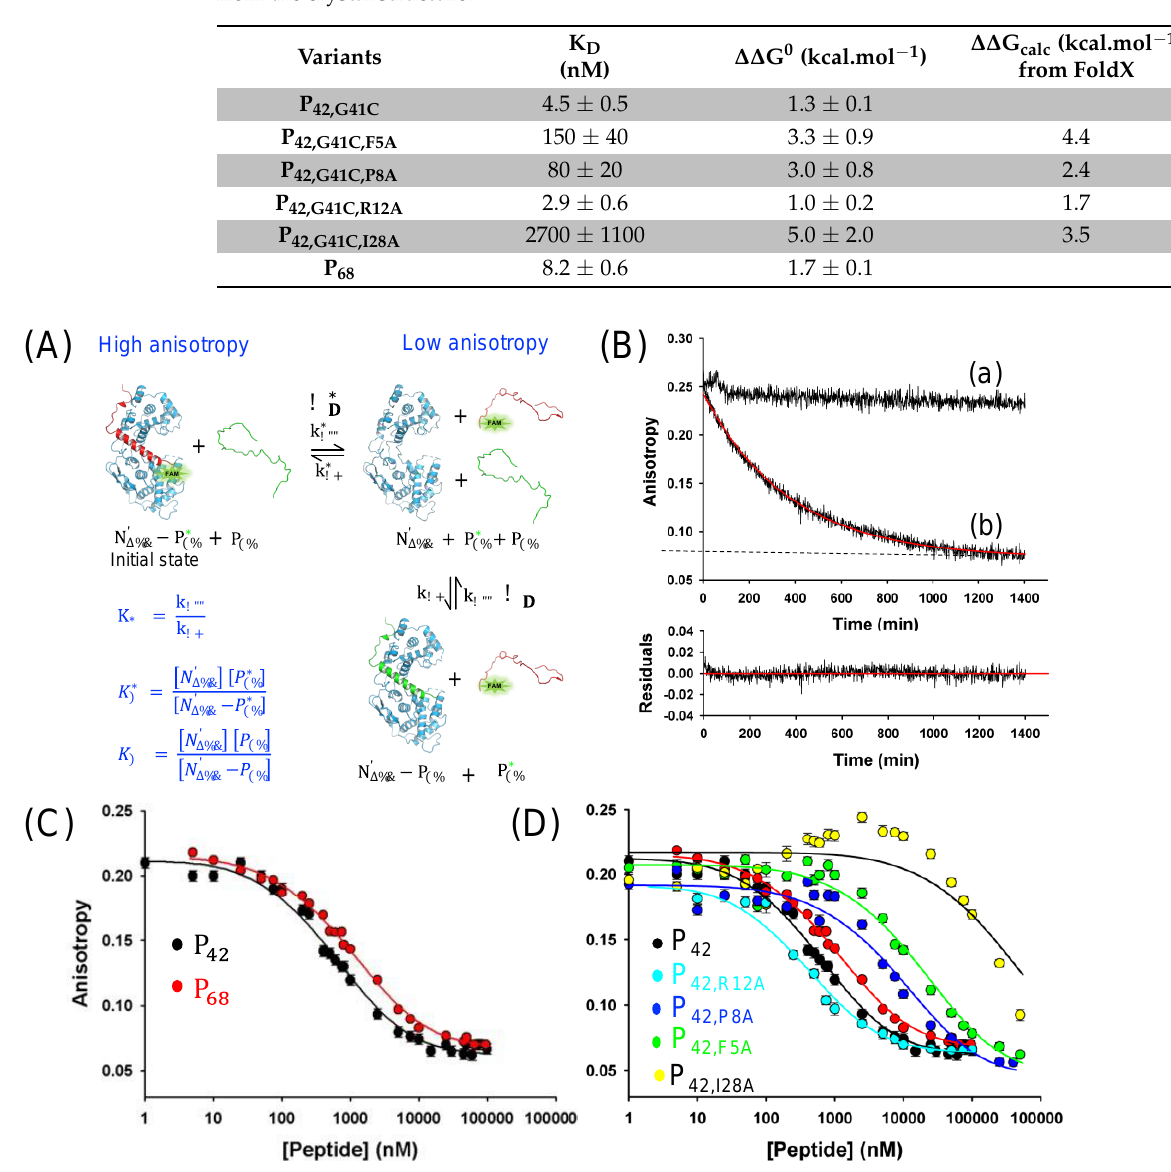
Figure 4. Competitive binding assay using fluorescence anisotropy. ( A ) Schematic representation of the competition assay and the mathematical models. ( B ) Dissociation kinetics; 200 µ L of N ∆ 230 − P 68 at a concentration of 100 nM in 20 mM Tris/HCl pH 7.5, 150 mM NaCl at 20 ◦ C. The upper panel shows the anisotropy variation in the absence (a) and presence (b) of a competing unlabeled peptide. The average anisotropy of P 68 − FAM alone is indicated by a dotted line. The red line shows the fit obtained with DYNAFIT. The lower panel shows the plot of the residuals for the fit obtained with DYNAFIT and shown in the upper panel. ( C ) Equilibrium binding curves with WT peptides. The black circles are for P 42 and the red circles for P 68 . The lines show the fits obtained with DYNAFIT and the parameters shown in Table 2. ( D ) Equilibrium binding curves with mutants. The black circles are for P 42 and are shown as reference. The light blue, dark blue, green, and yellow circles are for the mutant R12A, P8A, F5A, and I28A, respectively, and the lines show the fits obtained with DYNAFIT and the parameters shown in Table 2.